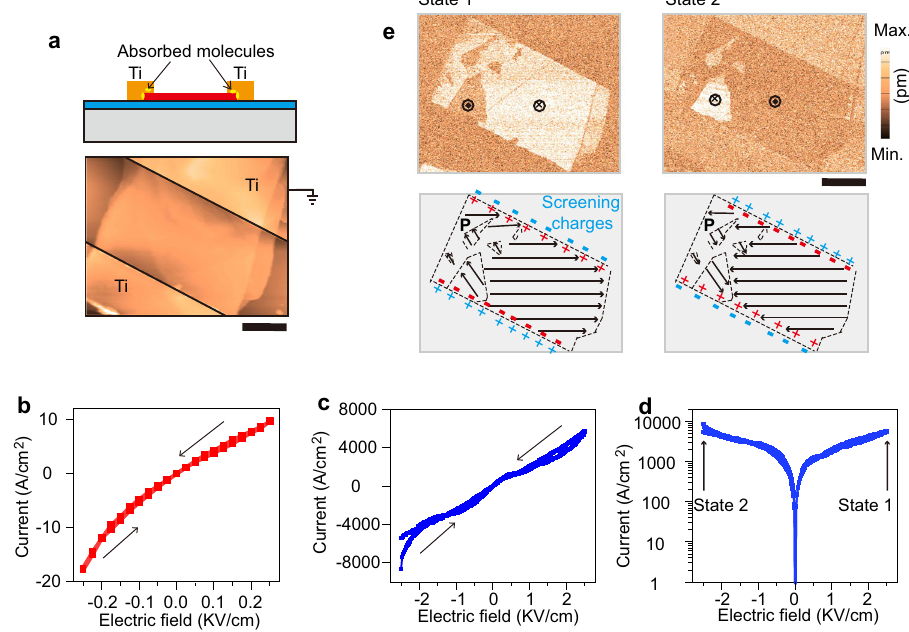
Fig. 3 An Ohmic contact device (Dev. 2) with completely screened ferroelectric polarization charges at interfaces. a Cross-sectional illustration of Dev. 2 having charged molecules at interfaces (yellow ovals at the top), and AFM image of the practical device (bottom). IV electrical curves with sweeping back and forth under ( b ) small and ( c ) large electric fi elds. Note that the small electric fi eld is below the ferroelectric coercive fi eld. Sweeping directions are marked by the black arrows in b and c . d Logarithmic plot of c . e PFM amplitude mapping of state 1 and state 2. The bottom shows the schematics of corresponding ferroelectric domain conformations. Screening charges, as shown by blue, can fully compensate for polarization charges. Scale bar in a and e : 2 μ